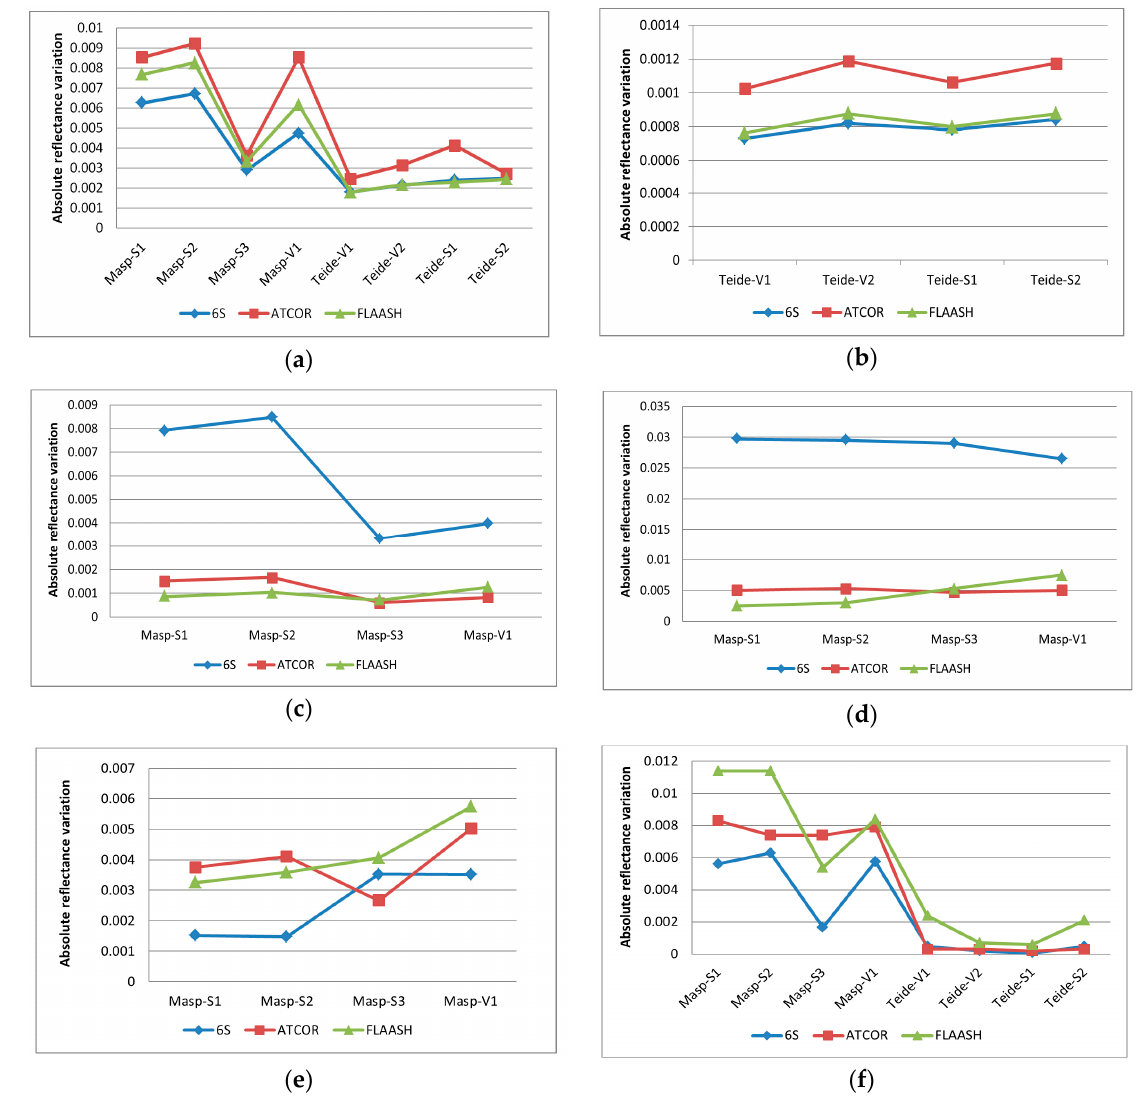
Figure 6. Absolute average reflectivity variation for Maspalomas (Masp) and Teide areas in soil (S) and vegetation (V) sites: ( a ) Tropical model with respect to the Mid-Latitude Summer model; ( b ) altitude of 2400 m with respect to 2250 m; ( c ) Rural aerosol model with respect to the Maritime model; ( d ) No aerosol model with respect to the Maritime model; ( e ) Maximum AOT (0.44) with respect the AOT of 0.25; ( f ) adjacency effect included with respect to the no inclusion of adjacency.